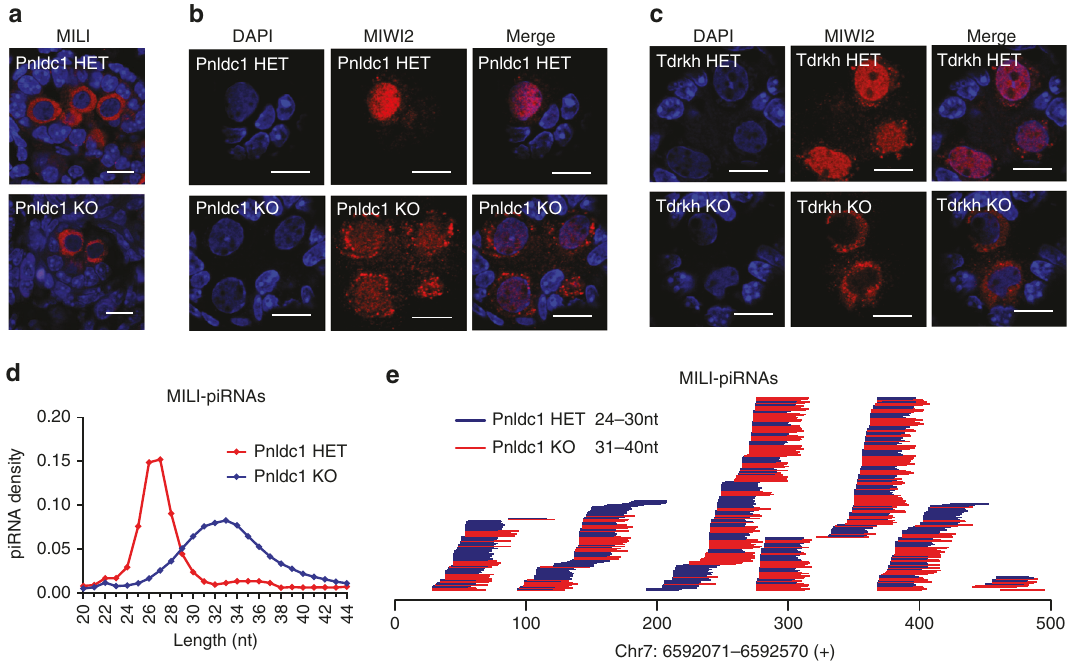
Fig. 7 PNLDC1 is required for pre-pachytene piRNA trimming. a Immunostaining of MILI on newborn (P0) testis sections from Pnldc1 HET and Pnldc1 KO mice. Scale bar , 10 μ m. b Immunostaining of MIWI2 on testis sections from Pnldc1 HET and Pnldc1 KO mice. MIWI2 is localized in both cytoplasm and nucleus in P0 Pnldc1 KO testes. Scale bar , 10 μ m. c Immunostaining of MIWI2 on P0 testis sections from Tdrkh HET and Tdrkh KO mice. MIWI2 exclusively localizes in the cytoplasm of P0 Tdrkh KO germ cells. Scale bar , 10 μ m. d The length distribution of MILI-piRNAs from P0 Pnldc1 HET and Pnldc1 KO